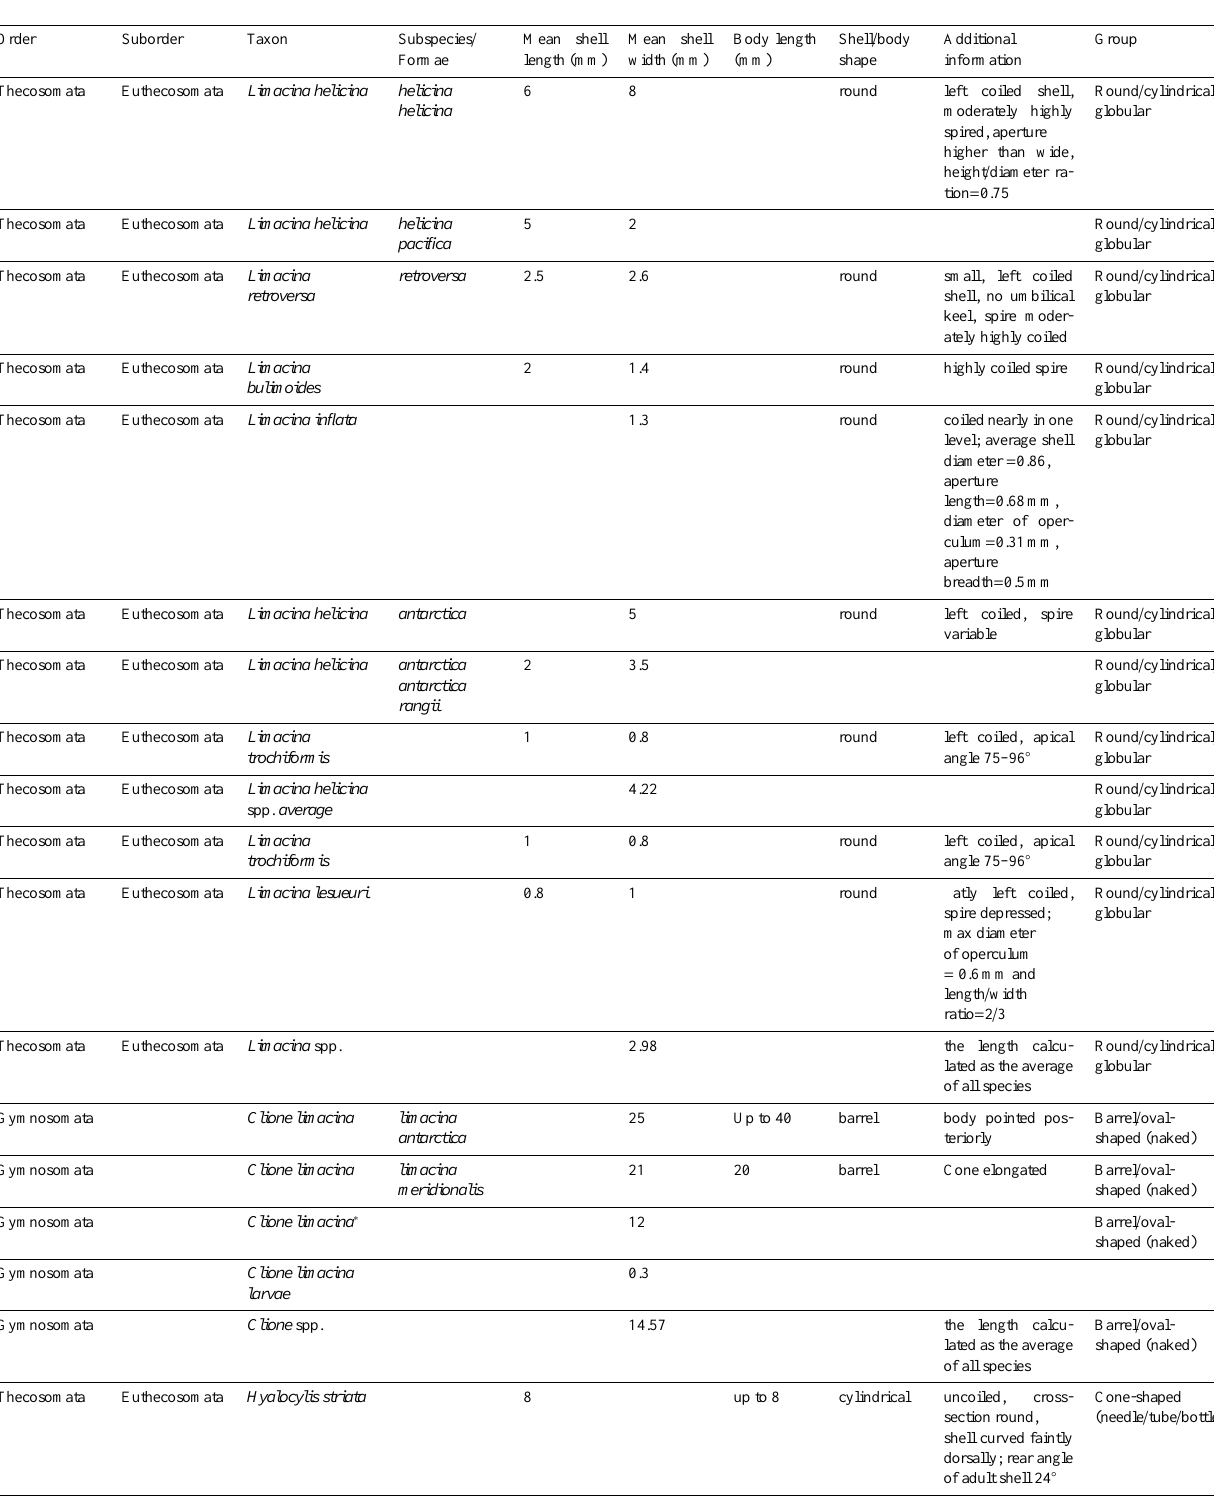
Table C1. Body dimensions and shapes of a range of shelled and non-shelled pteropod species (source: Marine identification portal (http: // species-identification.org / ), except for Clione limacina ∗ – B¨oer et al.,